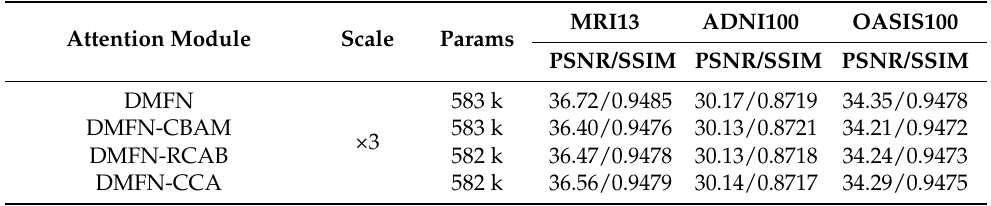
Table 5. Comparison of existing attention models and our CRB on DMFN.